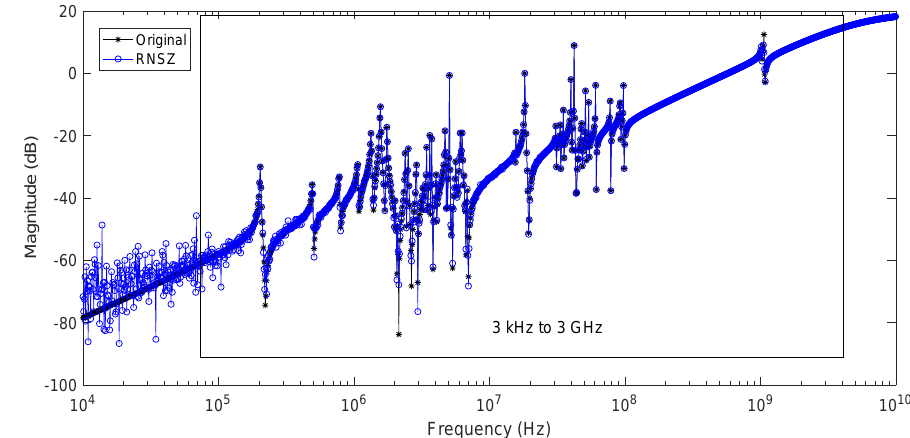
Figure 19. Original system frequency response of a spiral inductor (order n = 191) compared with a ROM generated using a high order (N = 186) RNSZ method covering 3 kHz to 3 GHz